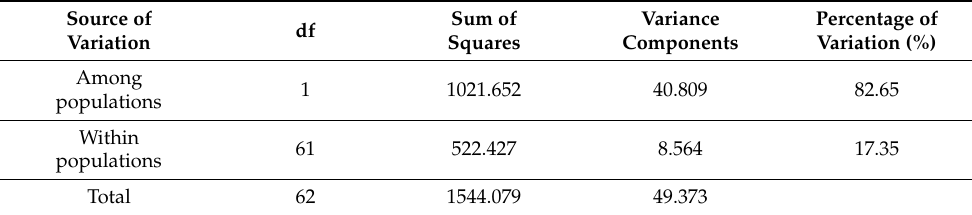
Table 3. Analysis of molecular variance among population and within population in Lumbriculus variegatus .